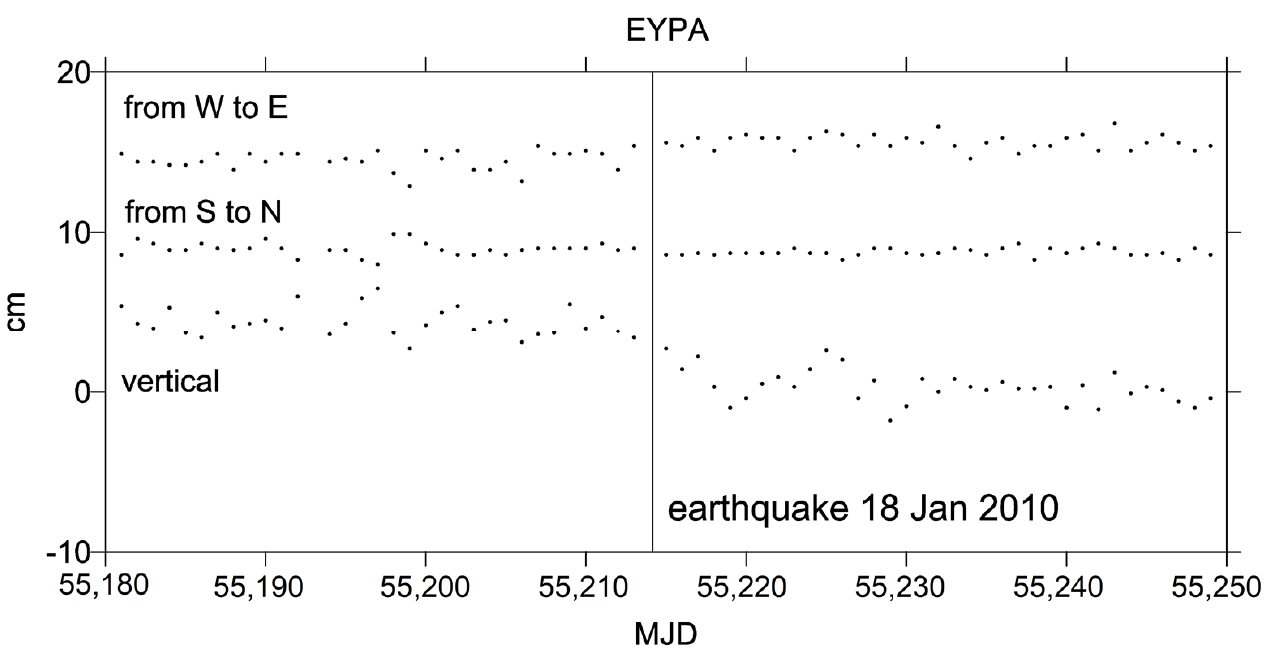
Figure 1. Horizontal (E-W, N-S) and vertical coordinate differences at the EYPA station—the daily PPP solution smoothed by the anharmonic analysis. The coordinates are positive towards East, North, and Up and shifted for better visualisation. The time scale is in the Modified Julian Date (MJD).